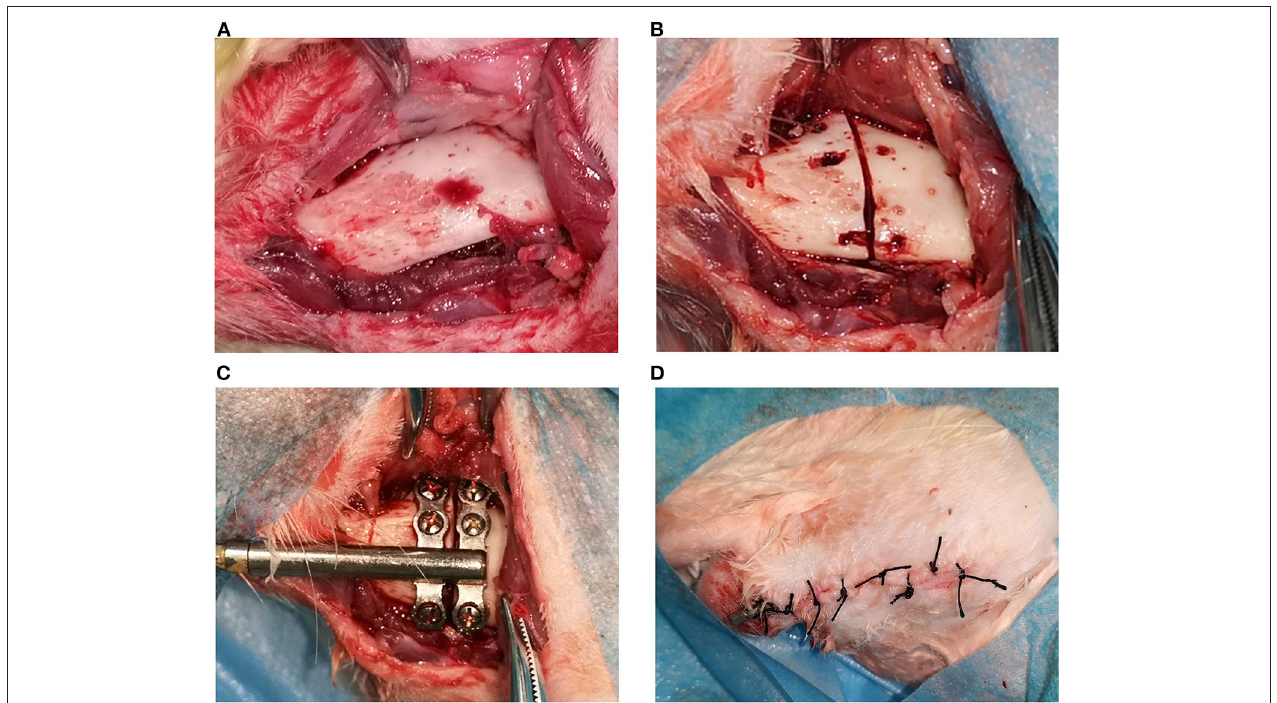
FIGURE 1 | The operation procedures of distraction osteogenesis: (A) demonstrates the exposed bone surface during incision; (B) shows the truncation of the bone cortex; (C) illustrates the installation of the distractor; Figures 1 – 4 shows the incision suture.